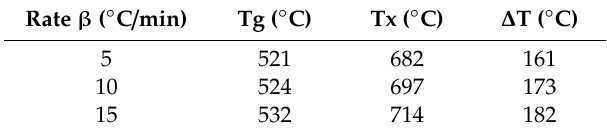
Table 1. Crystallization peak temperatures of 45S5 Bioglass ® for di ff erent heating